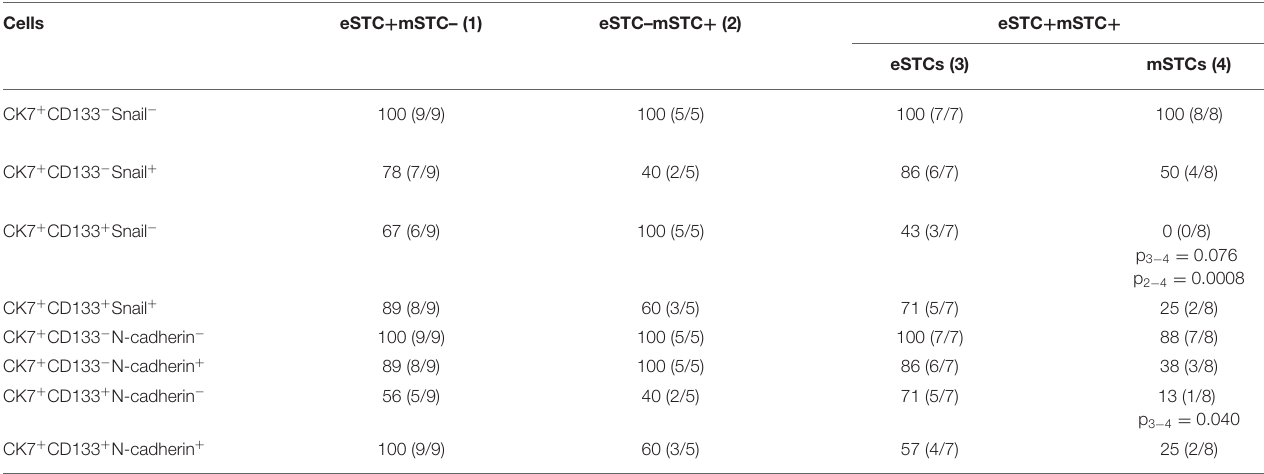
Fisher’s exact test. p 2 − 4 and p 3 − 4 , differences between groups of patients with only mSTCs (2) and simultaneously with eSTCs (3) and mSTCs (4).